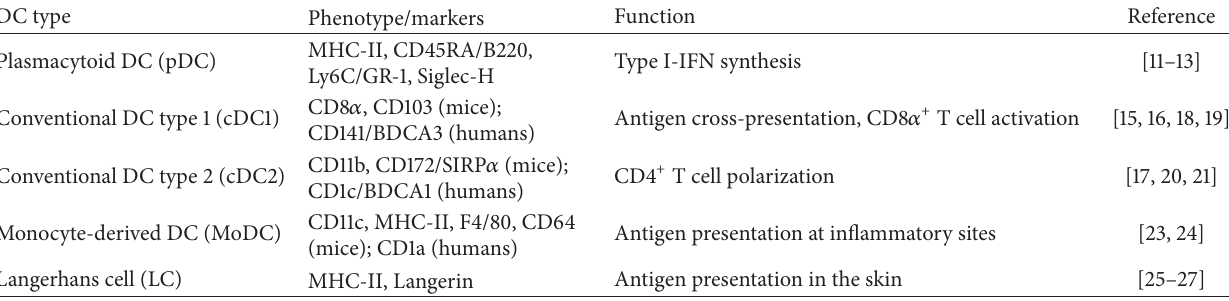
Table 1: Summary of current phenotypes described for different DC